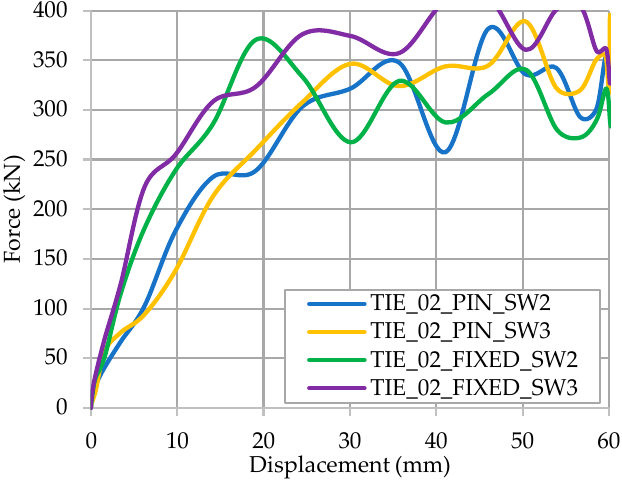
Figure 24. Force/displacement diagrams for 2 SW and 3 SW configurations of the pinned and fixed beam with full tie shear connection.